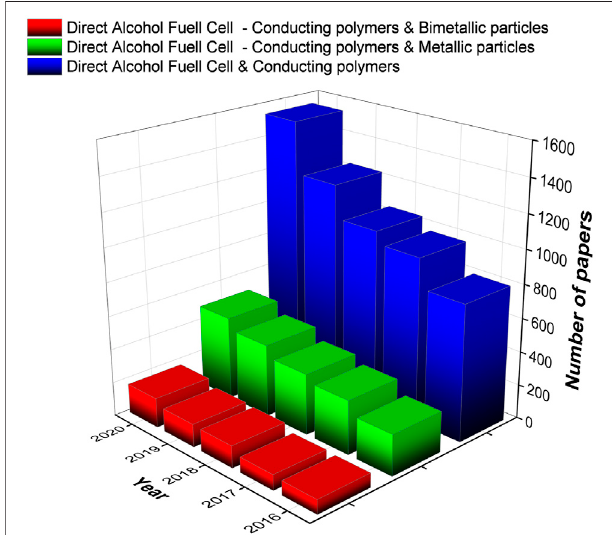
FIGURE 2 | Bar chart exhibiting the number of papers published during last 5 years ’ basis as given in Science Direct (Keywords: DAFC, CPs, Metallic particles, and Bimetallic